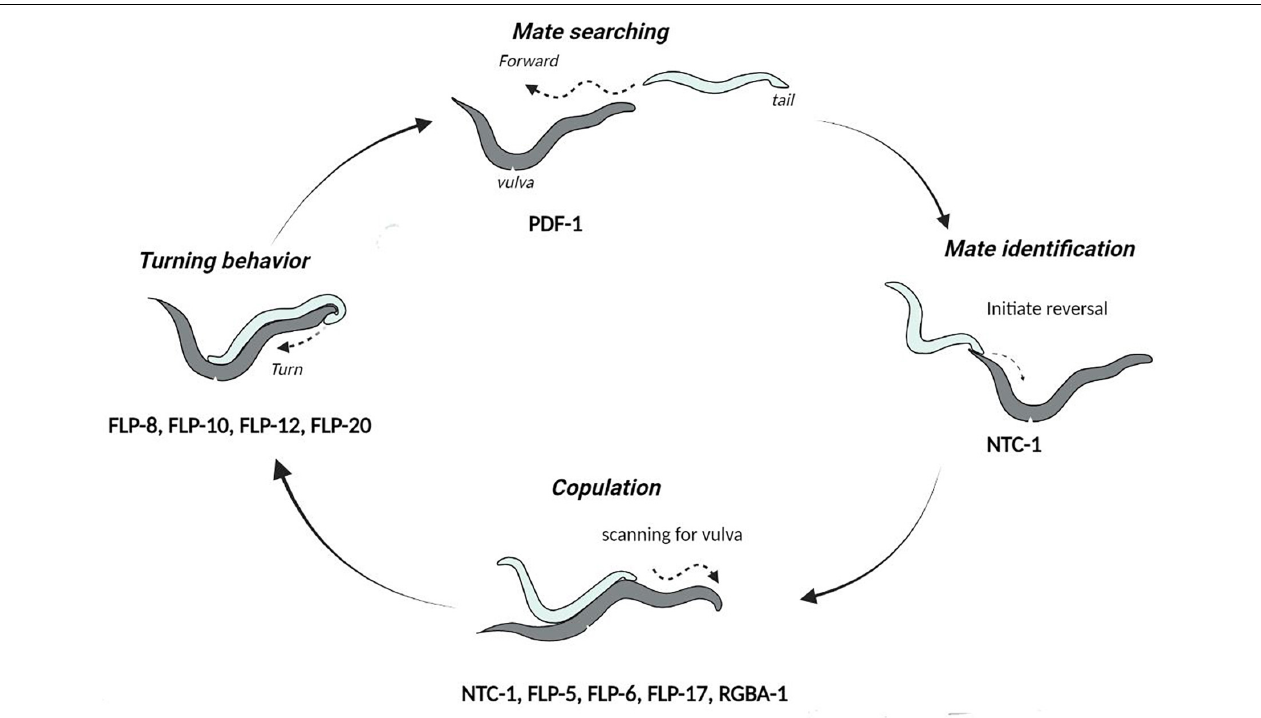
FIGURE 5 | Cycle of events during mating in C. elegans. The neuropeptides involved in each step of the mating behaviors are indicated below the step they function at. This image has been adapted from Sherlekar et al.